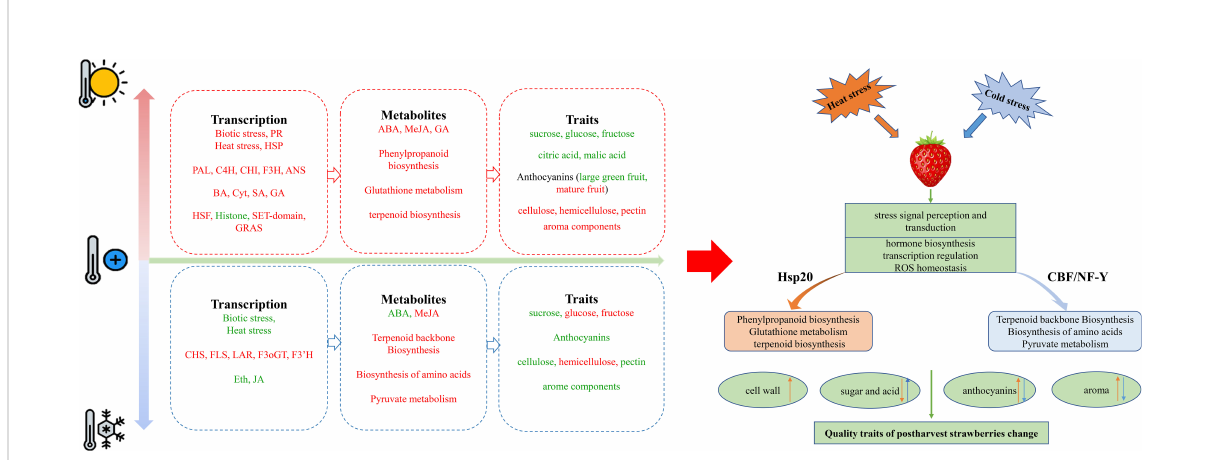
FIGURE 9 A summary of the presence of key genes, hormones, central and specialized metabolites in strawberry fruit during postharvest cooling and heat storage. Red and green represents the upregulated and down-regulated transcripts or compounds. Orange represents changes under heat stress, blue represents changes under cold stress. The up arrow represents increasing of compounds, and the down arrow represents decreasing of